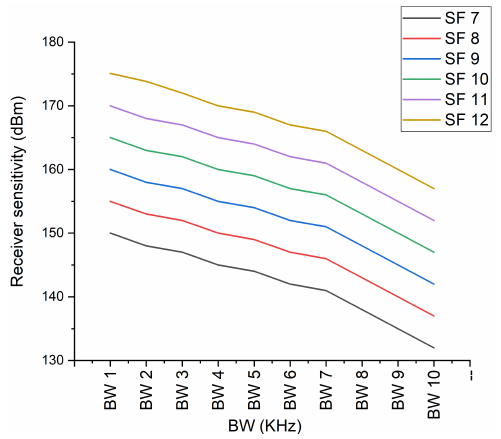
Figure 9. LoRa sensitivity from (SF 7–SF 12).